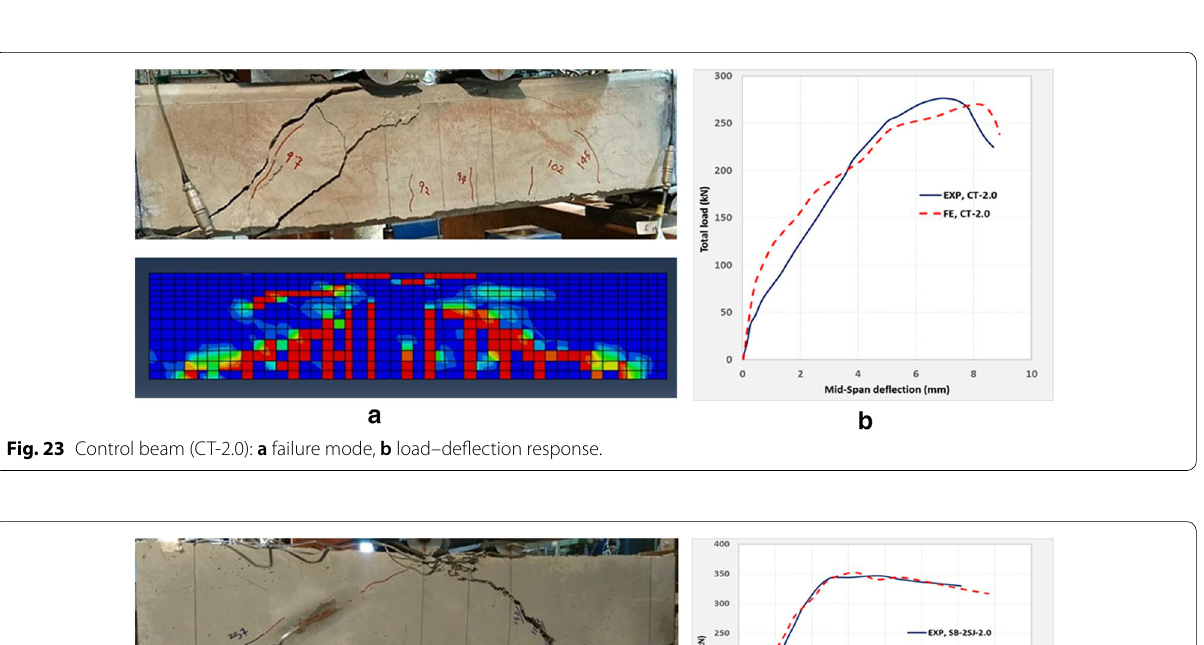
Fig. 22 Retrofitted beam (SB‑3SJ‑1.5): a failure mode, b load–deflection response.